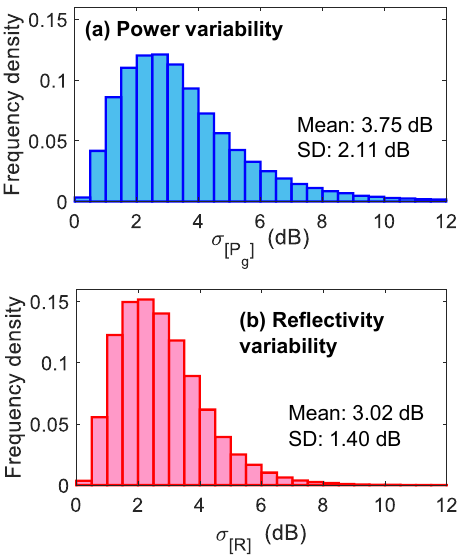
Figure 4. Frequency distributions for (a) bed-echo power vari- ability, σ [ P (corresponding to Fig. 3a); (b) bed-echo reflectiv- g ] ity variability, σ [ R ] (corresponding to Fig. 3c). Later in the study σ [ R ] > 6dB is used as the threshold criteria for diagnosing the pres- ence of basal water.